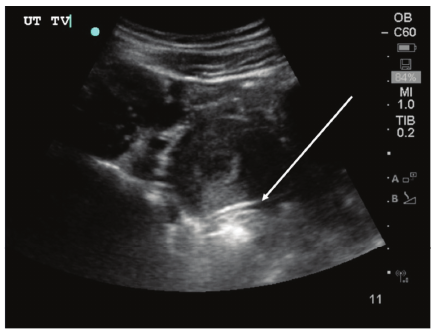
Figure 2: Utilizing a Sonosite C60 2–5MHz curvilinear transducer, thistransabdominalultrasoundimagedisplaysanemptyuteruswith a thinsliver of hypoechoic fluid posteriorto theuterinewall